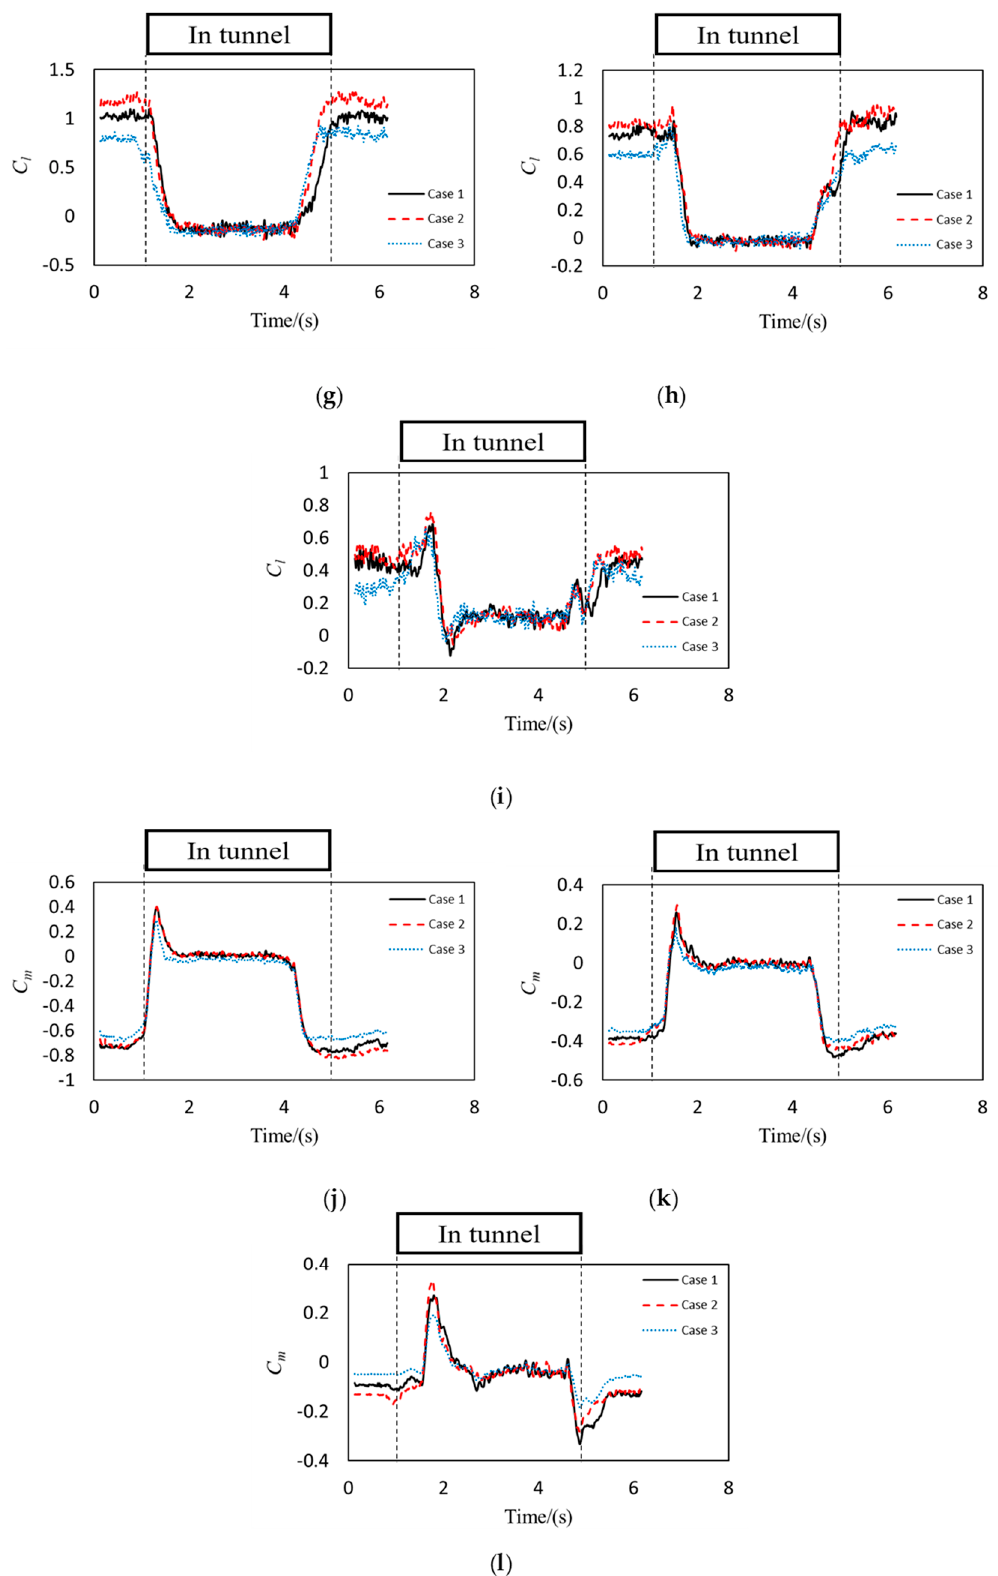
Figure 10. Curves of aerodynamic coe ffi cients for three cars: the head car (HC), the middle car (MC), Figure 11. Curves of aerodynamic coefficients for three cars: the head car (HC), the middle car (MC), and the tail car (TC). ( a ) C d of HC ( b ) C d of MC; ( c ) C d of TC; ( d ) C s of HC; ( e ) C s of MC; ( f ) C s of TC; and the tail car (TC). ( a ) (cid:1829) (cid:3031) of HC ( b ) (cid:1829) (cid:3031) of MC; ( c ) (cid:1829) (cid:3031) of TC; ( d ) (cid:1829) (cid:3046) of HC; ( e ) (cid:1829) (cid:3046) of MC; ( f ) (cid:1829) (cid:3046) of ( g ) C l of HC; ( h ) C l of MC; ( i ) C l of TC; ( j ) C m of HC; ( k ) C m of MC; ( l ) C m of TC; ( g ) (cid:1829) (cid:3039) of HC; ( h ) (cid:1829) (cid:3039) of MC; ( i ) (cid:1829) (cid:3039) of TC; ( j ) (cid:1829) (cid:3040) of HC; ( k ) (cid:1829) (cid:3040) of MC; ( l ) (cid:1829) (cid:3040) of TC.